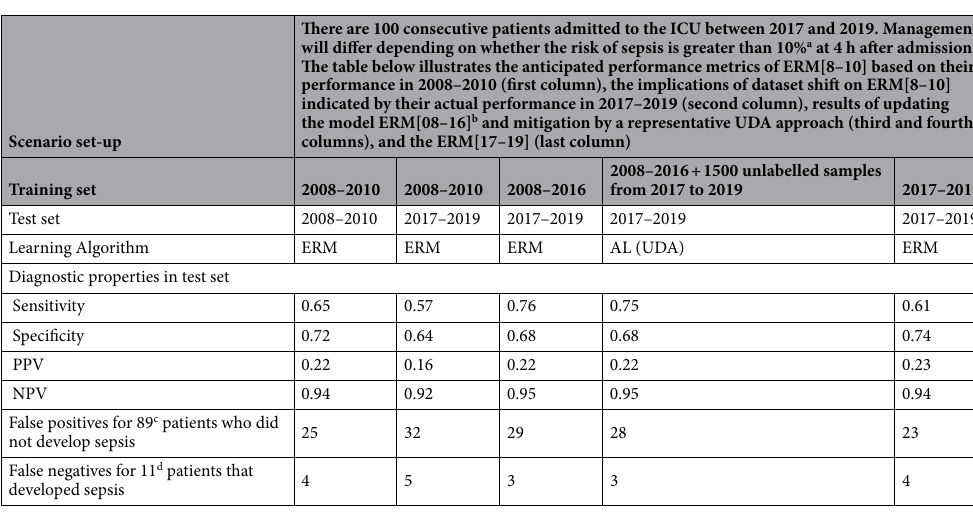
Table 2. Clinical interpretation of temporal dataset shift in sepsis prediction. Sepsis was chosen as this task exhibited the most discrimination deterioration due to temporal dataset shift. ERM: empirical risk minimization; AL: domain adversarial learning; UDA: unsupervised domain adaptation. a 10% threshold for sepsis was chosen as a clinically reasonable value although results across thresholds from 5 to 45% are shown in Supplementary Table S5. b ERM[8–16] models are the fair ERM comparators to DG and UDA models given they were trained using 2008–2016. c,d Outcome prevalence was estimated based on average sepsis prevalence from 2008 to 2019. The table illustrates the results of initial model development with training and evaluation in the earliest period or 2008–2010 (first column), which represents performance anticipated by clinicians applying the model to patients admitted in 2017–2019 if the model is not updated. The second column shows actual performance of that model on their patients, or the impact of temporal dataset shift. In other words, the first two columns illustrate the clinical impact of temporal dataset shift for the task with the most extreme dataset shift, namely sepsis. It shows that for the 11 patients who developed sepsis, the false negative rate increased by 1 patient. The table also shows the impact of retraining with the more updated data (third column), and one approach to mitigate dataset shift, namely AL (UDA) (fourth column). Results of AL (UDA) was almost identical to third column (ERM[8–16]). For illustrative purposes, it also shows the ERM[17–19] in which training and test sets are both 2017–2019